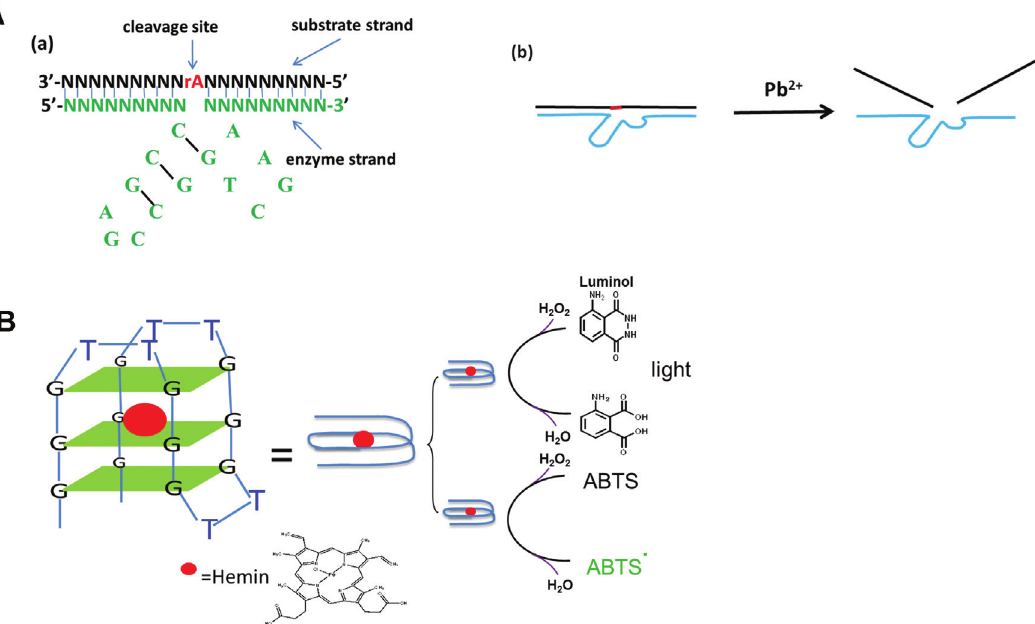
Figure 1 (A): (a) Secondary structure of the 8–17 DNAzyme; (b) cleavage of substrate strand by enzyme strand in the presence of Pb 2+ . (B) Proposed secondary structure of DNAzyme peroxidase (left), DNAzyme can catalyze the conversion of luninol with chemiluminescence generation (right up) and conversion of ABTS with color generation (right